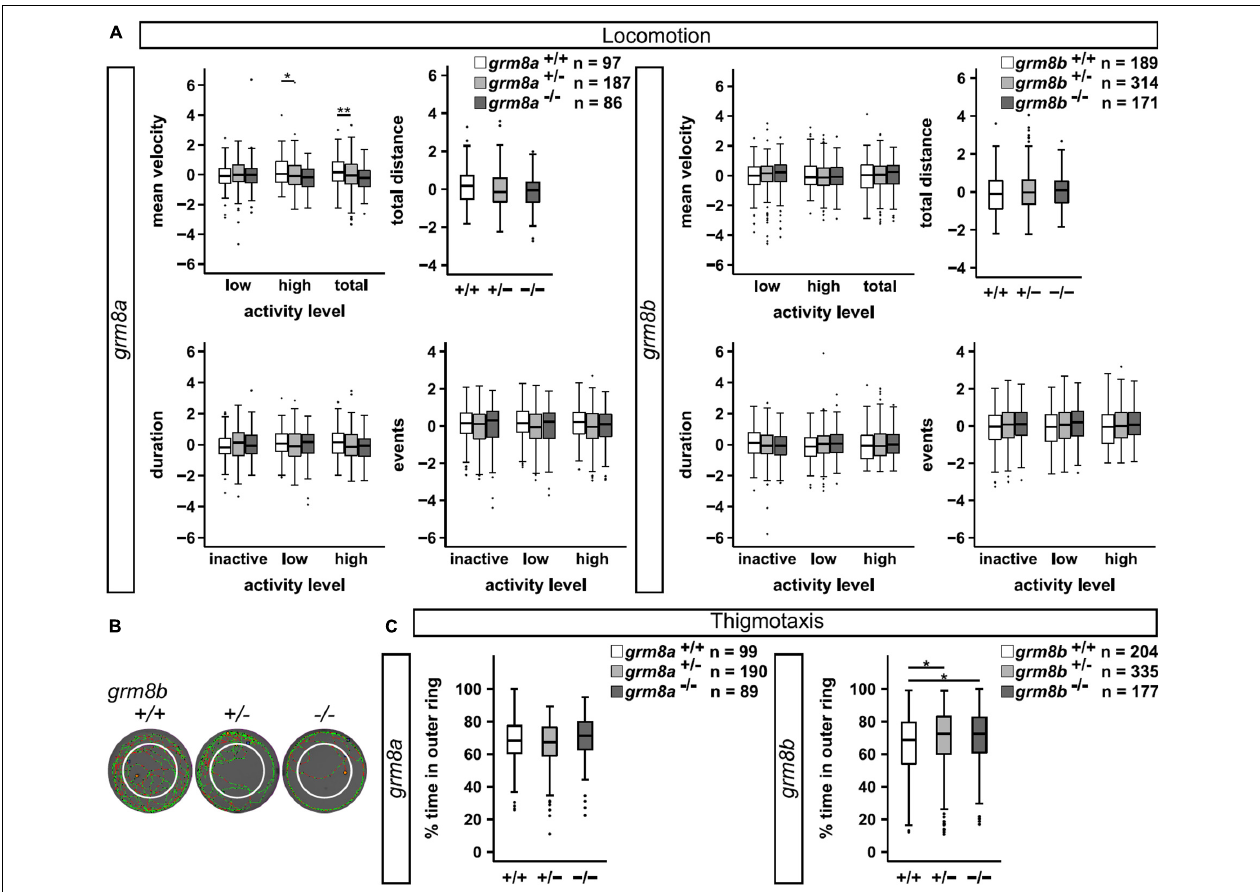
FIGURE 6 | Behavioral characterization of grm8a and grm8b larvae. (A) Locomotor activity of grm8a (left panel) and grm8b mutant animals (right panel) were analyzed for mean velocity (top left) in low or high activity, or combined (total), total distance swum (top right), duration (bottom left) and events (bottom right) of inactivity, low and high activity. Raw data was standardized using z-score transformation. * P < 0.05, ** P < 0.01. (B) Example traces of grm8b + / + , grm8b + / − , and grm8b − / − animals analyzed for thigmotaxis behavior. Note the reduced movement of mutant animals in the inner zone. Green represents slow, red fast movement. (C) Analysis of thigmotaxis behavior in grm8a (left panel) and grm8b (right panel) mutant animals. Time spent in the outer ring was analyzed for all genotypes and raw data standardized using z-score transformation. * P <